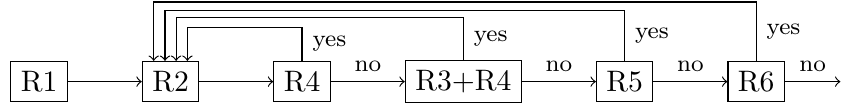
Figure 7: The rule application strategy for the formal verification of Boolean to arithmetic